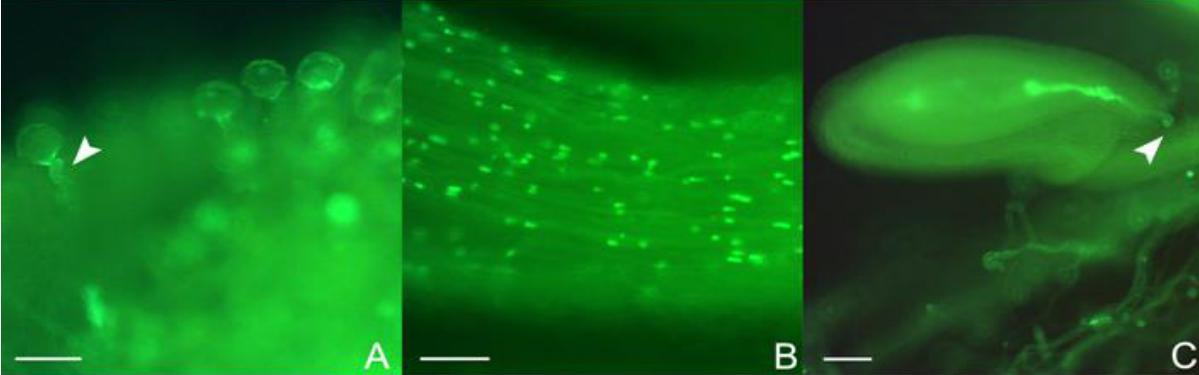
F IGURE 3. Assessment of self-compatibility in Passiflora herbertiana. (A) Pollen grains germinating on the style. Arrow indicates pollen tube. (B) Example of pollen tubes germinating through the centre of the style in a self-pollinated individual. (C) View of a fertilized ovule in a self- pollinated individual. Arrow indicates pollen tube penetrating the micropyle and reaching the nucellus. Scale bars: a, c = 50 µm; b = 100 µm.